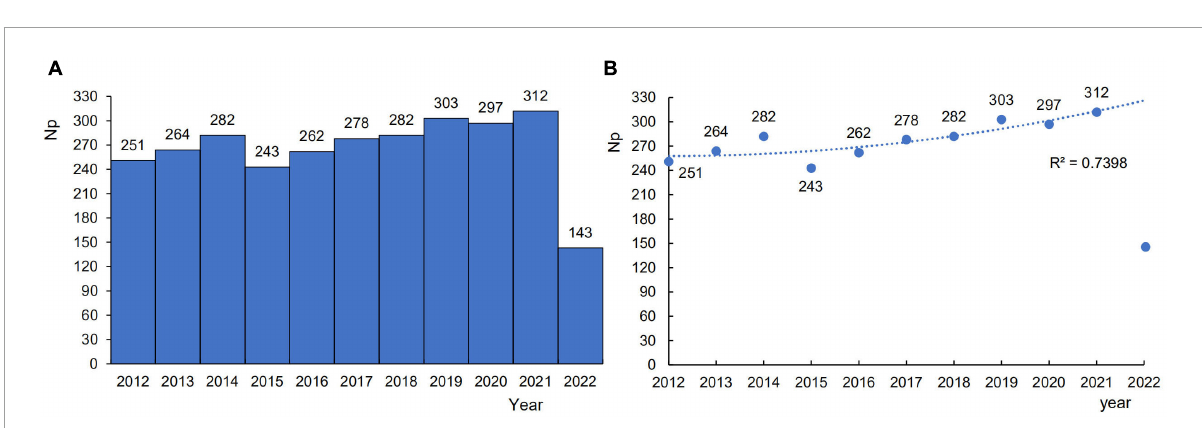
FIGURE1 Retrieval strategies from the Web of Science Core Collection (WoSCC) and inclusion criteria for Helicobacter pylori -related gastric ulcer (GU) articles.